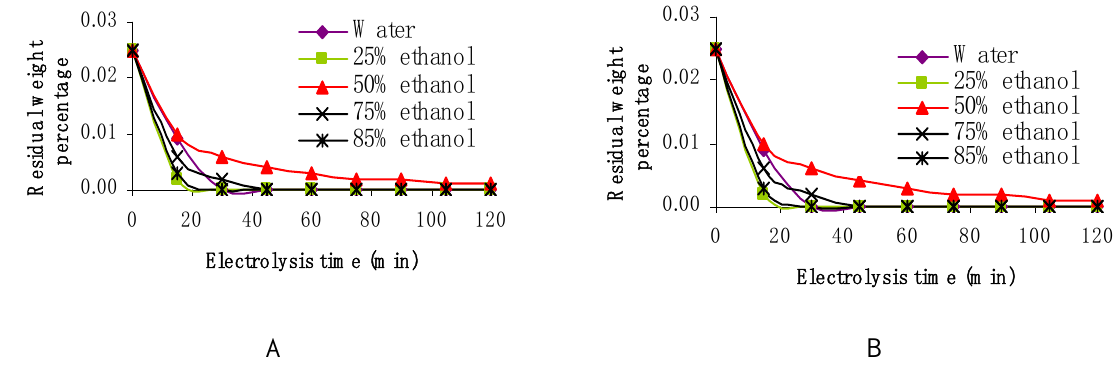
Figure 2 . Plots of residual weight percentage and electrolysis time for each ethanol concentration of crocin solution at 440 nm; A: with aluminium as electrodes, B: with iron as